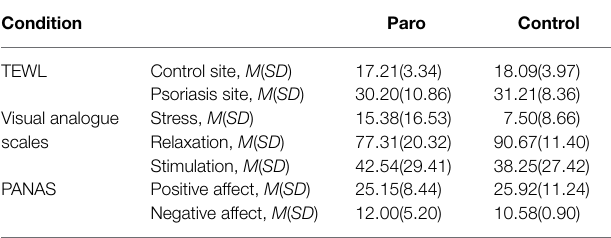
M, mean, SD, standard deviation, and TEWL, trans-epidermal water loss, there were no significant differences in any outcomes between conditions (all ps >